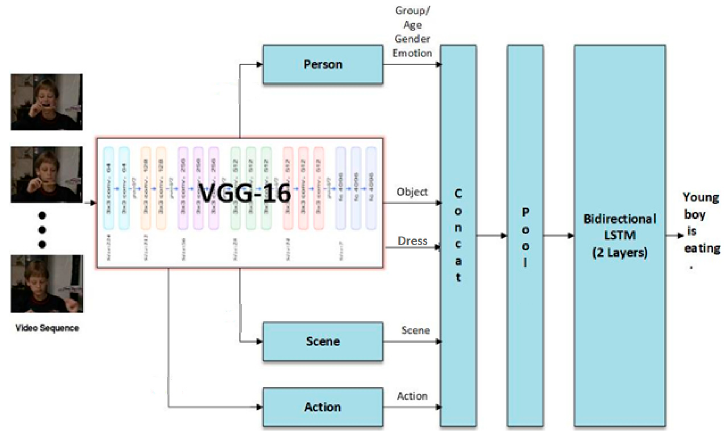
Figure 1. Block diagram of the multitask learning framework.